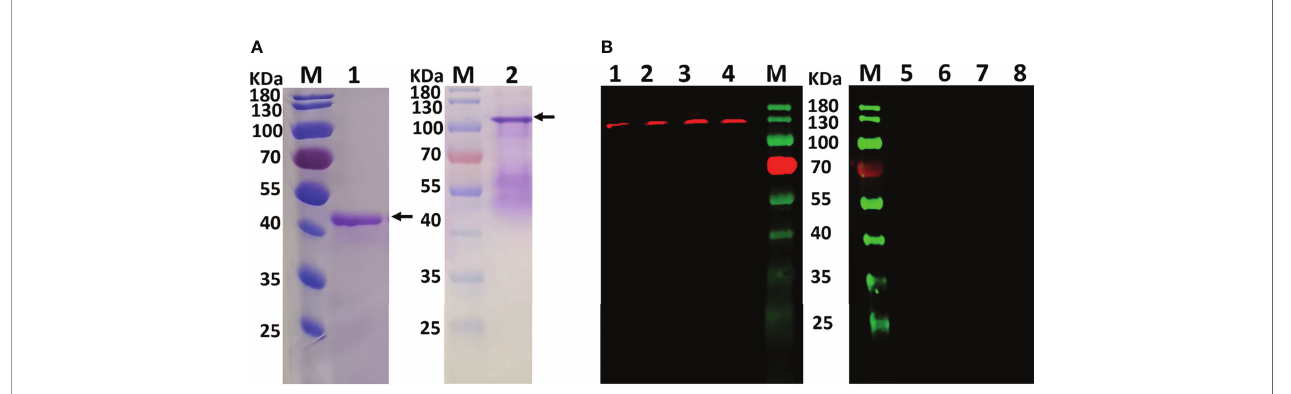
FIGURE 3 | (A) Puri fi ed rSmFGFRA-L (lane1) and rSmFGFRA (lane 2) observed in SDS-PAGE gels. (B) Western blot analysis using an anti-rSmFGFRA-L polyclonal antibody to probe S. mansoni SWAP (lane1), S. japonicum SWAP (lane 2), S. haematobium SWAP (lane 3), and S. mansoni SEA (lane 4). The naïve mouse serum served as a negative control to probe S. mansoni SWAP (lane 5), S. japonicum SWAP (lane 6), S. haematobium SWAP (lane 7), and S. mansoni SEA (lane 8).